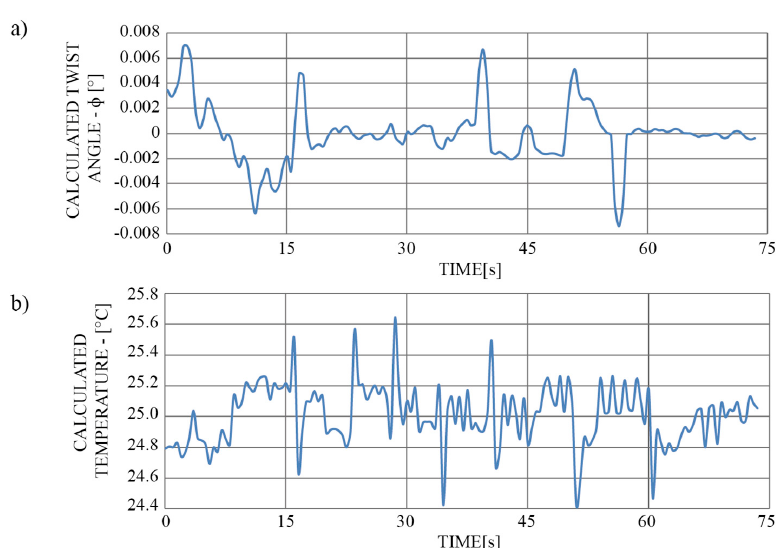
Figure 11. ( a ) Influence of the change in the sensor length for 4 µ m on the twist/rotation angle readout and ( b ) Calculated temperature change instigated from elongation.